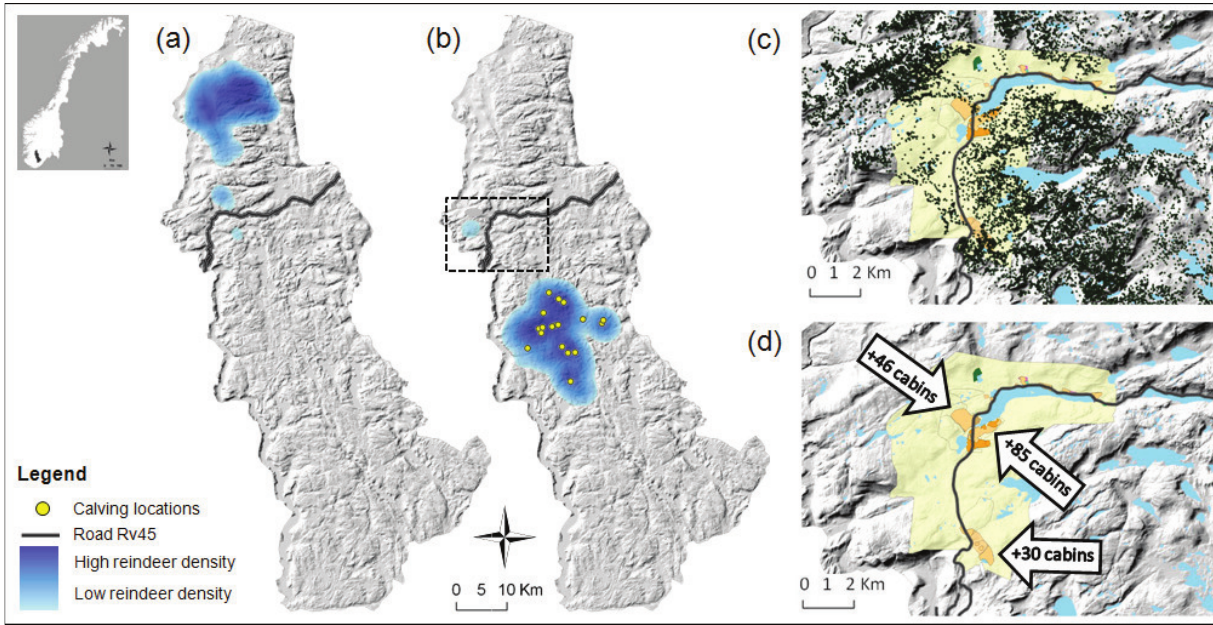
Fig. 1. The Setesdal Austhei study area. The location of a) winter (February) and b) calving range May15th – June 30th are represented by a 95% kernel density of the GPS radio-collar locations of 10 female reindeer monitored from 2002 to 2010. In (b) the yellow dots represent the locations of the calving events ( n = 20) estimated for each individual each year. The dashed rectangle in b depicts the location of the area illustrated in (c), reindeer GPS radio- collar locations indicating the location of the two migration corridors, and (d), details of the land development plan for Bjørnevatn, indicating the planned location of the construction of several cabins for recreational